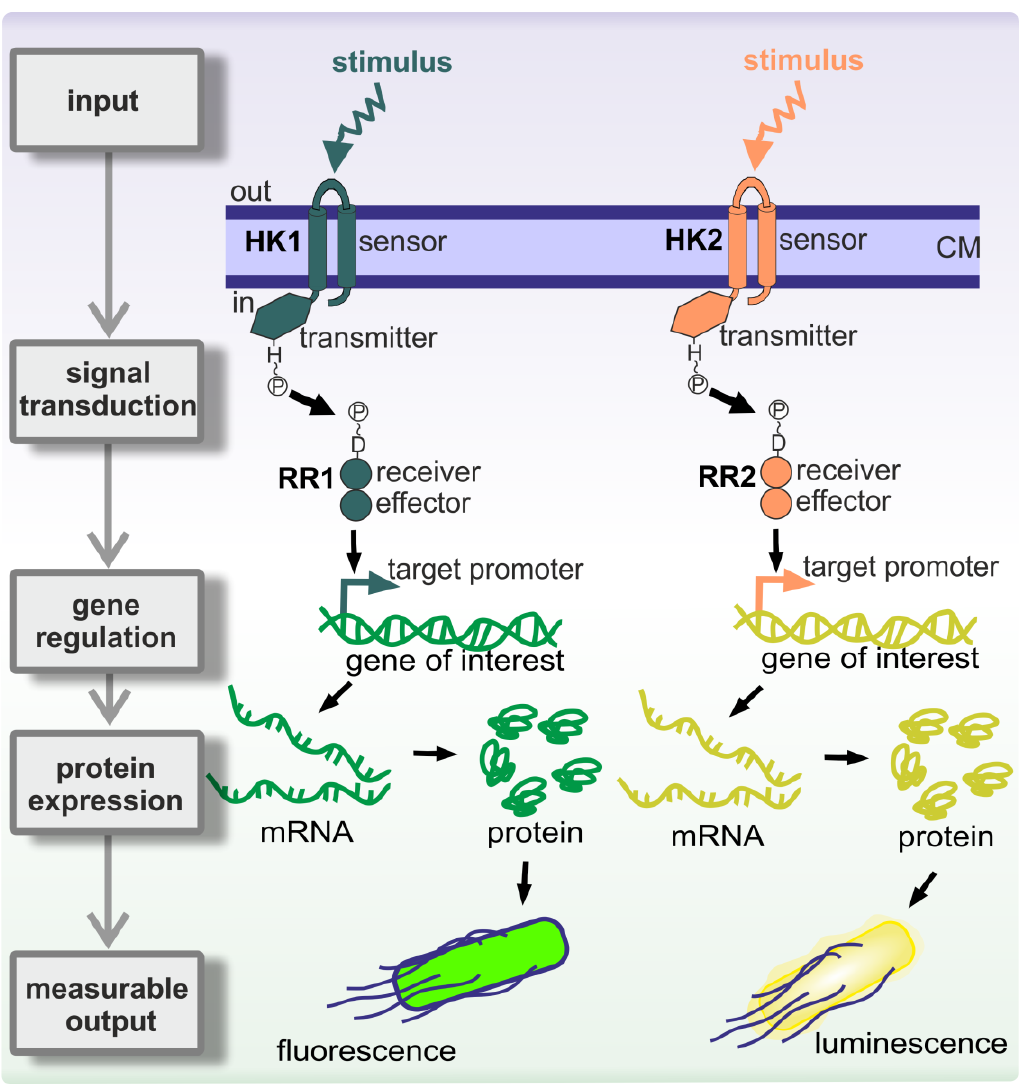
Figure 2. Two-component system (TCS)-based signal transduction in bacteria connects specific inputs with measurable output responses. Schematic showing two TCSs sensing two different external inputs (stimulus), leading to the activation of their corresponding target promoters and concomitant gene expression. This results in expression of green fluorescent protein in the case of TCS1 or luminescence in the case of TCS2. In both cases, the response can be experimentally measured. See main text for details on TCS signal transduction mechanistic. HK, histidine kinase; RR, response regulator; CM, cell membrane.